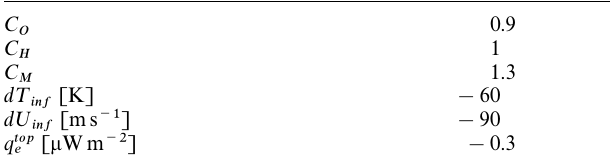
Table 1. List of adjustment parameters at 1500 UT for atomic oxygen O ( C (cid:79) ), atomic hydrogen H ( C (cid:72) ), atomic nitrogen and molecular components O (cid:50) and N (cid:50) ( C (cid:77) ), departure from exospheric temperature ( d „ (cid:105)(cid:110)(cid:102) ) and exospheric meridional wind ( d ” (cid:105)(cid:110)(cid:102) ) and topside electron heat flow (positive upward) C